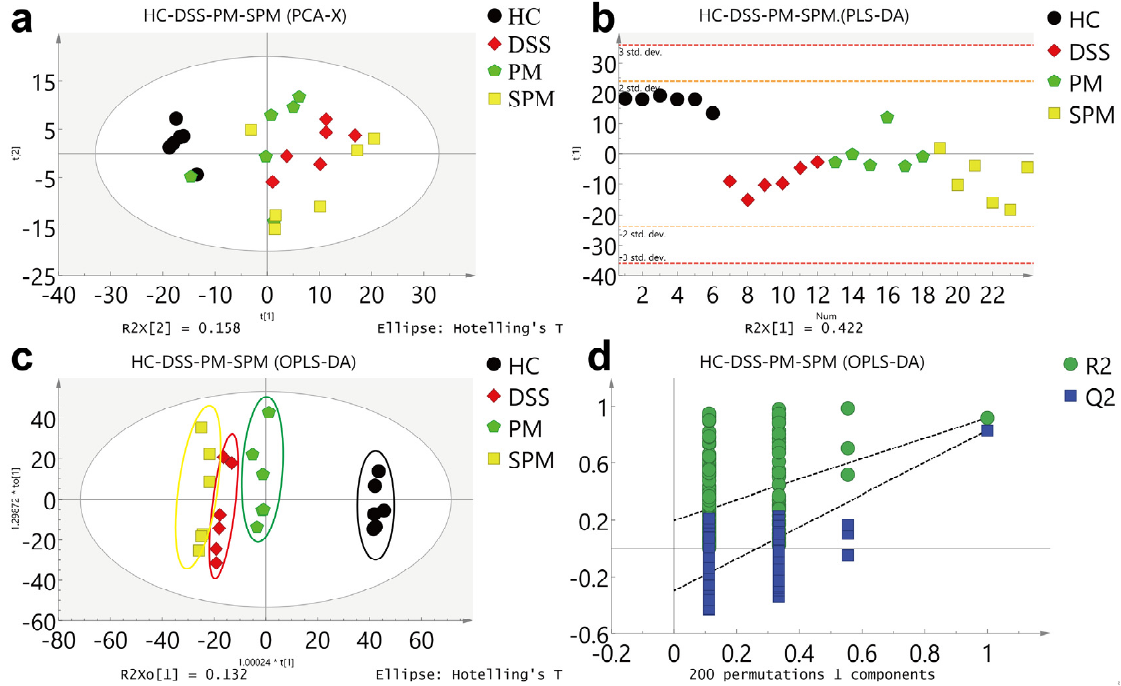
Figure 4. Multivariate statistical analyses of 1 H NMR spectra of the HC, DSS, PM, and SPM groups. ( a ) PCA score map; ( b ) PLS score map; ( c ) OPLS score map; ( d ) The validation model of OPLS-DA.